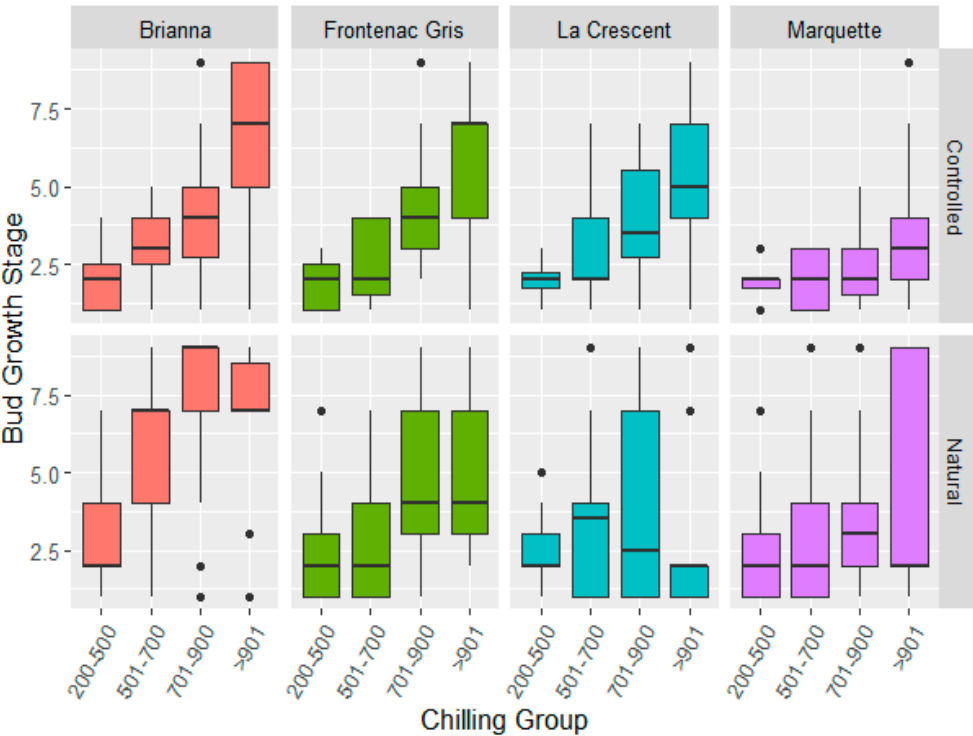
Figure 3. Cultivar bud break changes in response to similar chilling hour groups in controlled and natural chilling hour accumulation conditions in 2017/18, 2018/19, and 2019/20 dormant seasons. Table 3. Bud phenology stage determined after 4 weeks forcing for Brianna, Frontenac gris, La Crescent, and Marquette for 200–500, 501–700, 701–900, or >901 chilling hour accumulation in controlled (4 °C) and natural field conditions.